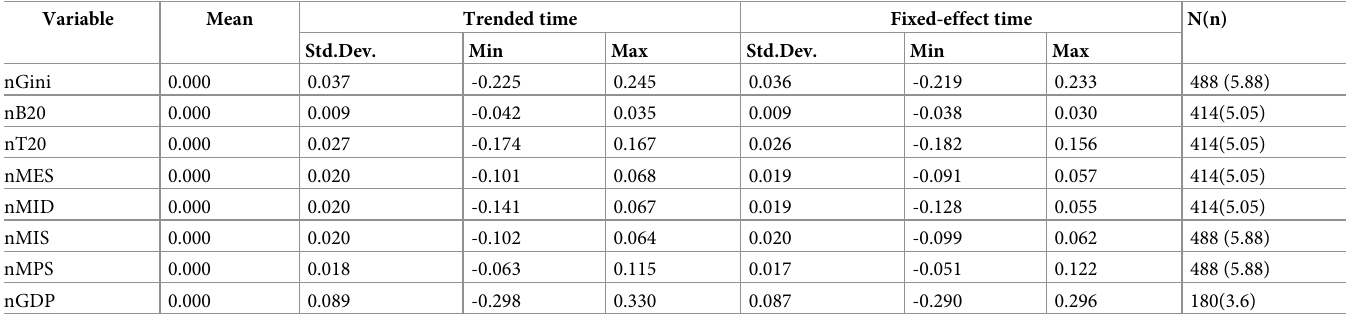
Table 3. Summary statistics of selected new variables (quasi-cross-sectional data). Variable